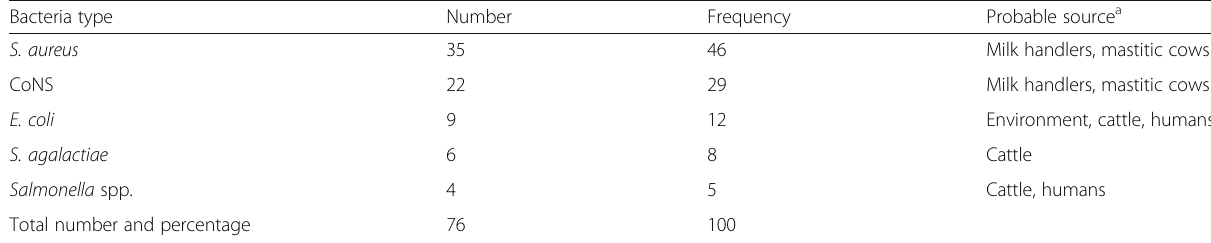
a S. aureus and CoNS are frequently shed from the nostrils of humans and infected udders of cows; E. coli is associated with human and cattle (animals) faecal matter and is shed into the soil and water; S. agalactiae is associated with infected udder while Salmonella can be shed by infected humans and